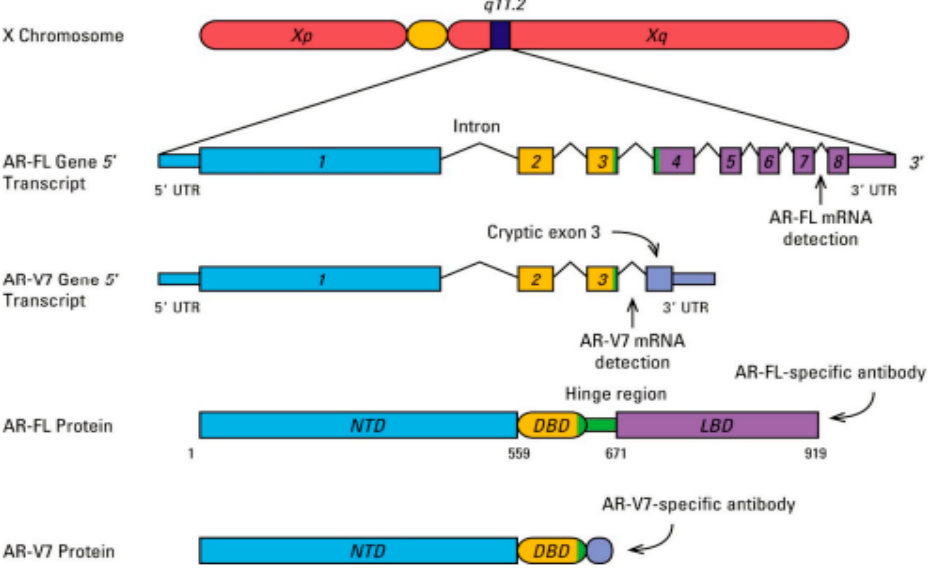
Figure 3. The androgen receptor gene encodes a 110 kD protein composed of 919 amino acids that are classified by an androgen-binding domain (ABD), a conserved DNA-binding domain (DBD), and an N-terminal transactivation domain, which has two polymorphic trinucleotide repeat segments. These repeated segments, consisting of variable numbers of polyglycine repeats and polyglutamine, highly influence the androgen receptor transcription activity. The gene transcript consists of eight exons in total: exon 1 codes for the N-terminal domain, exons 2–3 code for the DBD, and exons 4–8 code for the ABD [135].